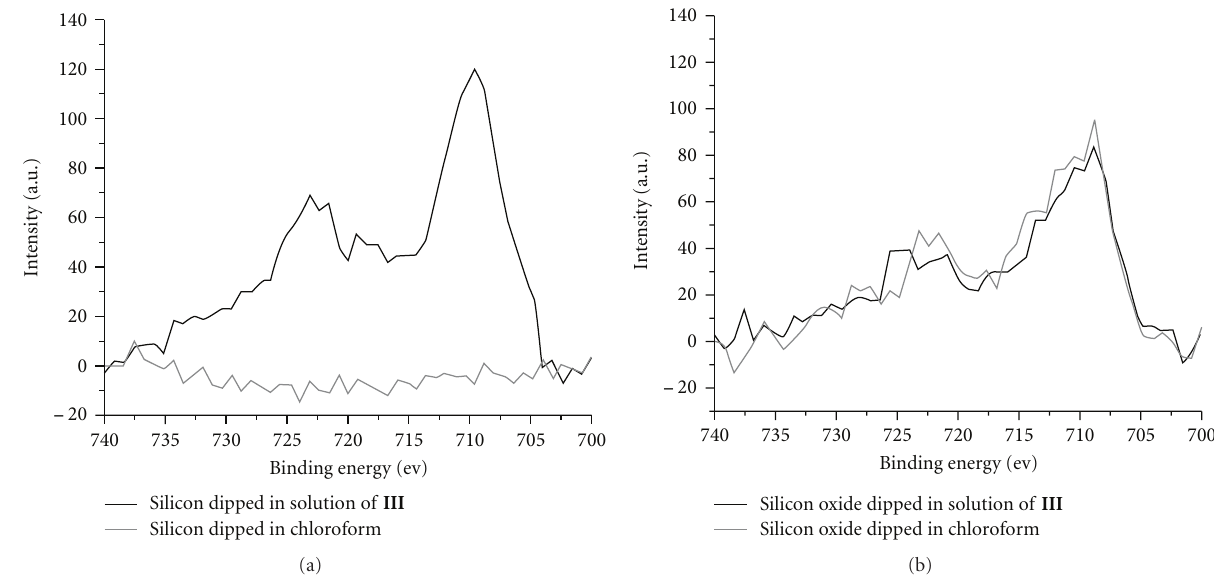
Figure 4: The XPS spectra of the Fe2p peak for (a) a silicon substrate treatment with a chloroform solution of III and a reference substrate treated with pure chloroform and (b) a silicon oxide substrate after treatment with a chloroform solution of III and a reference substrate treated with pure